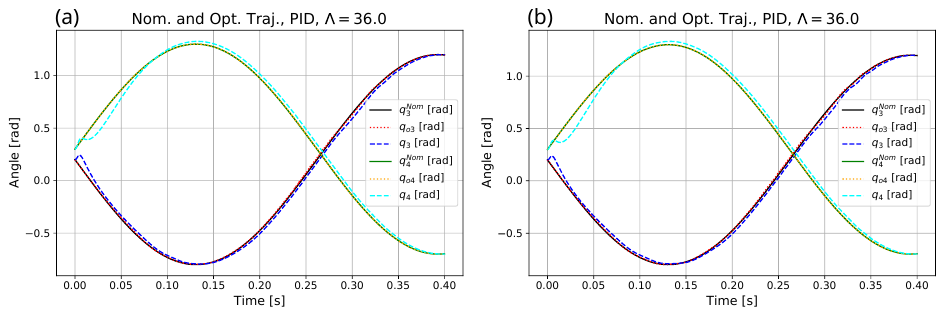
Figure 4. Trajectory tracking without force limitation for q 3 and q 4 . ( a ) For the set 1. ( b ) For the set